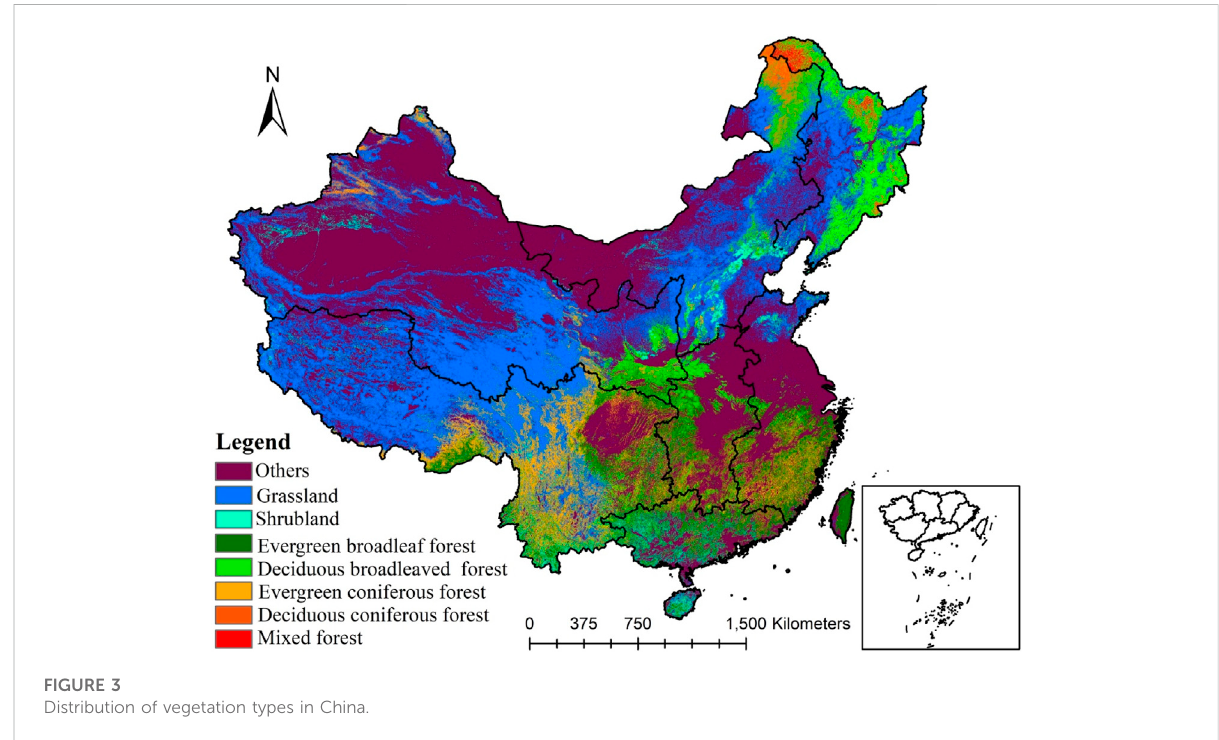
FIGURE 3 Distribution of vegetation types in China.